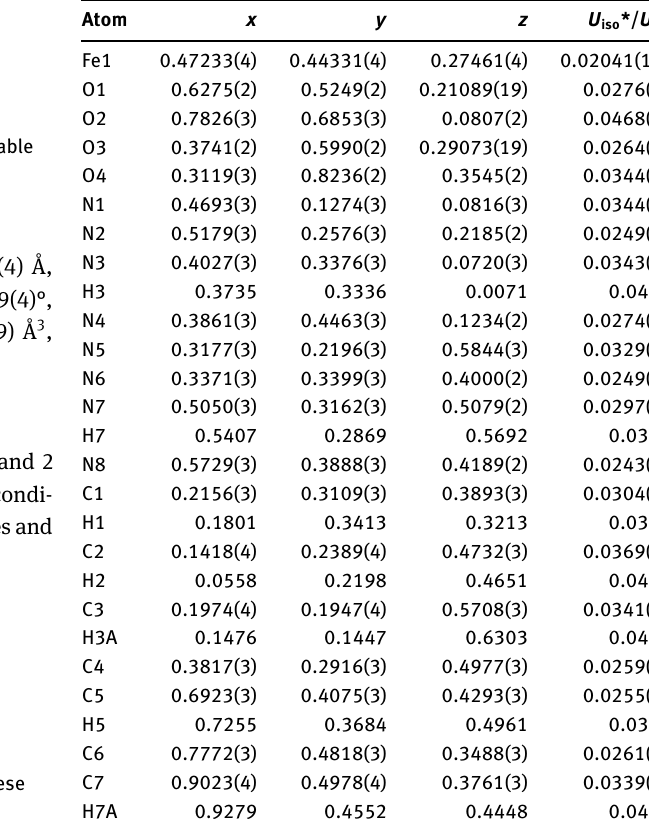
Table 2: Fractional atomic coordinates and isotropic or equivalent isotropic displacement parameters (Å 2